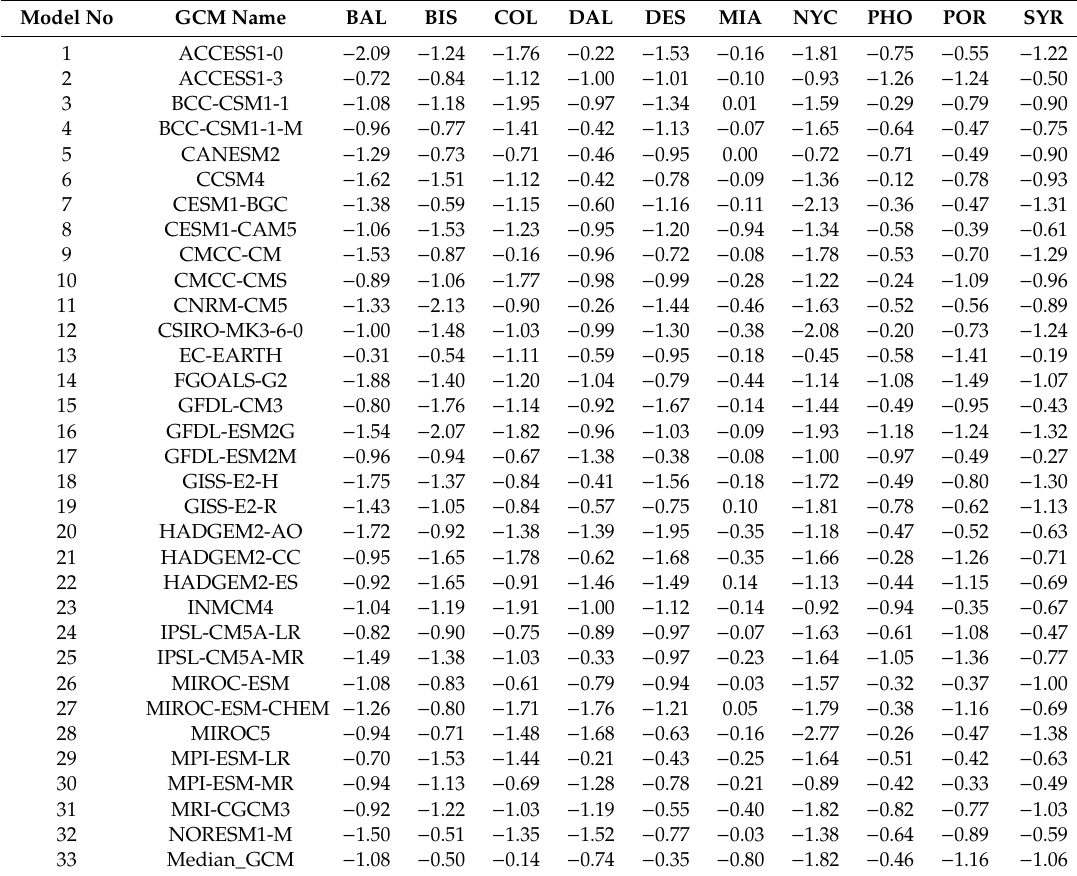
Table A9. NSE coe ffi cient of Intensity between observed and simulated data (1950–2005).